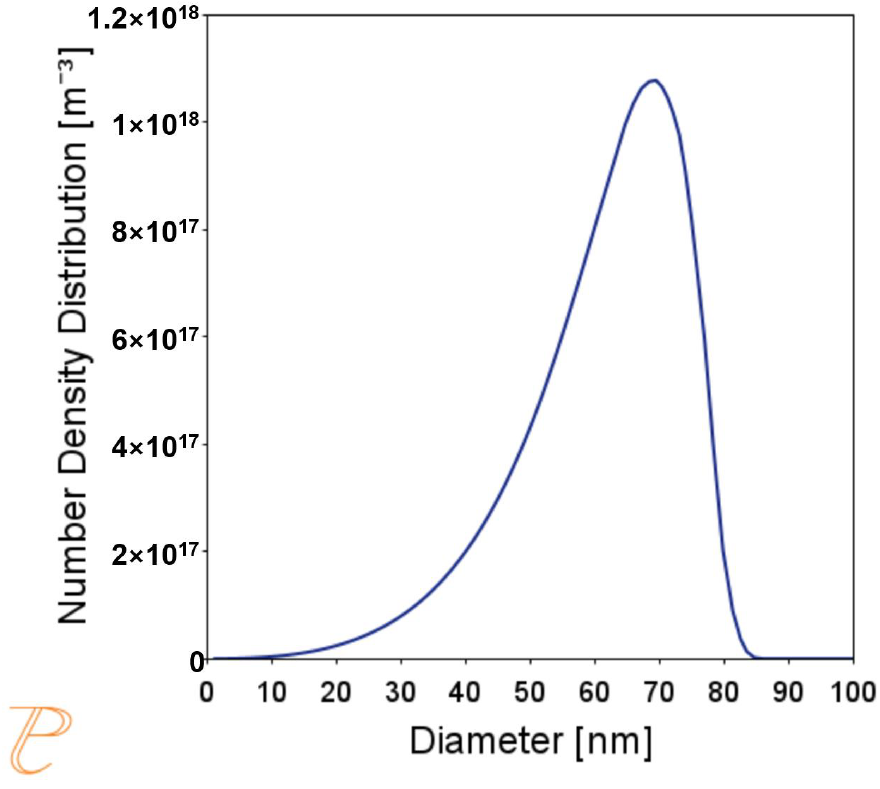
Figure 9. . Figure 9. Thermo-Calc calculation using the precipitation module TC-PRISMA of the resulting number density distribution of nitride precipitates in the matrix as a function of their diameter after 50